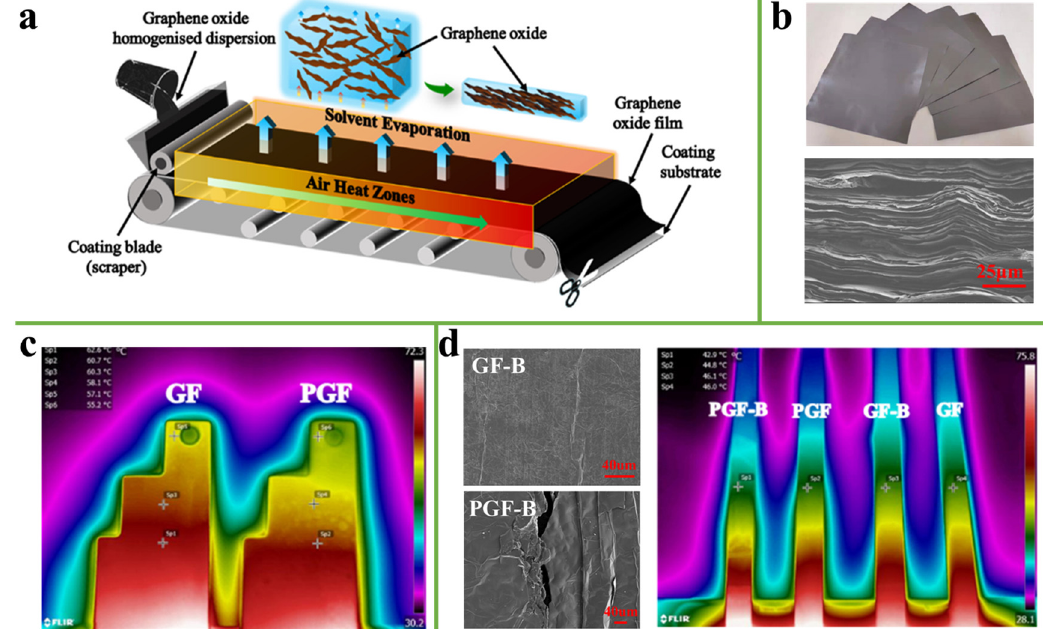
Figure 3. ( a ) The Schematic of the fabrication process of the GO film. ( b ) Optical image of the GFs with different thicknesses and cross-sectional SEM image of pressed GFs-2850. ( c ) Infrared thermal images of 220 μ m GF and PGF in a standard template. ( d ) SEM image of the surface morphology change of GF and PGF after the bending test, respectively, and infrared thermal images of GF and PGF before and after the bending test. Reprinted with permission from ref. [38] Copyright 2020, Elsevier.